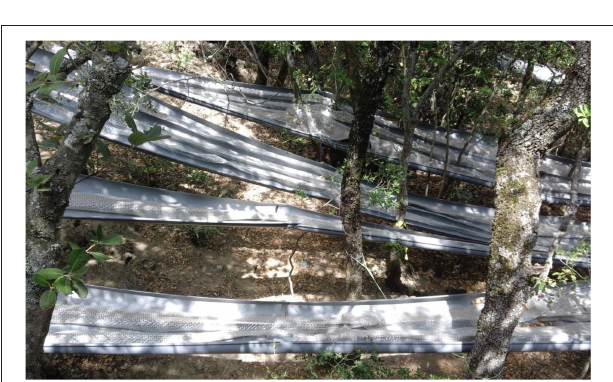
FIGURE 2 | Throughfall Displacement Exclusion system installed to decrease soil moisture and water availability for the vegetation.